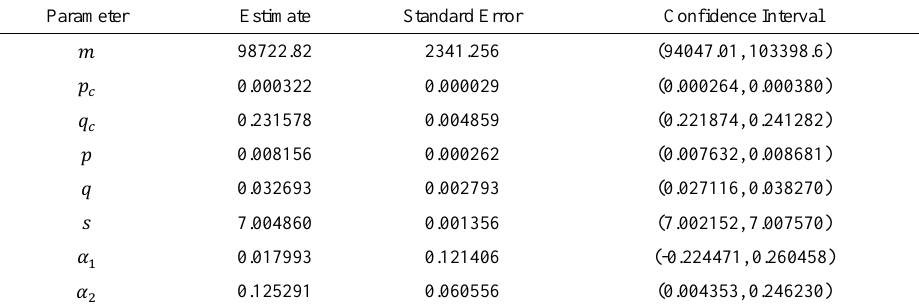
Table A11. Lombardy. Estimates, asymptotic standard errors and 95% mCIs for the parameters of the DMPseas